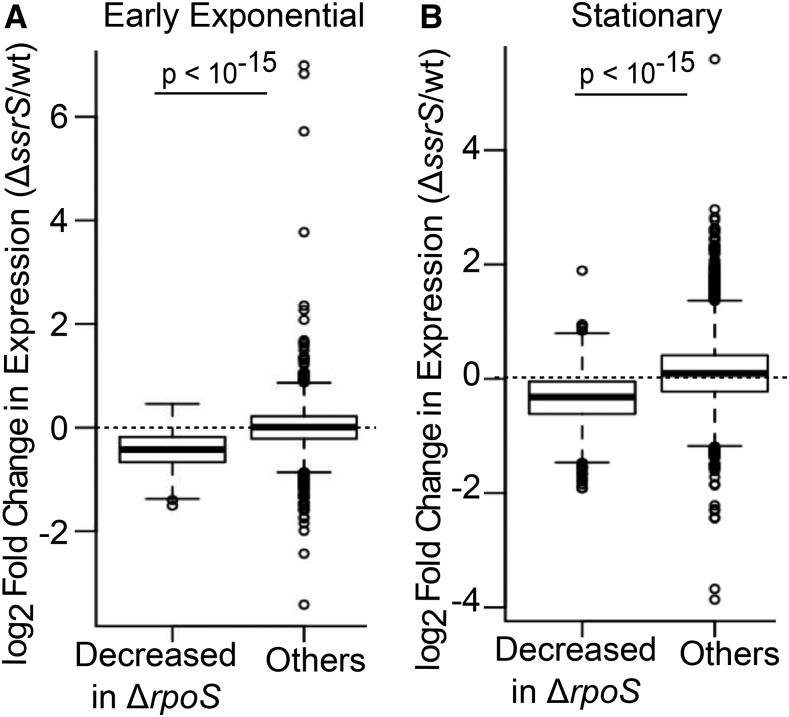
6S RNA regulates RpoS target genes throughout growth. (A) Boxplot of log2 fold change in gene expression (ΔssrS/wild-type, EE phase) for 313 genes whose expression is reduced at least twofold in ΔrpoS/wild-type in EE phase, compared to all other genes. (B) Boxplot of log2 fold change in gene expression (ΔssrS/wild-type, stationary phase) for 634 genes whose expression is reduced at least twofold in ΔrpoS/wild-type in stationary phase, compared to all other genes. p-values are for Wilcoxon Test.